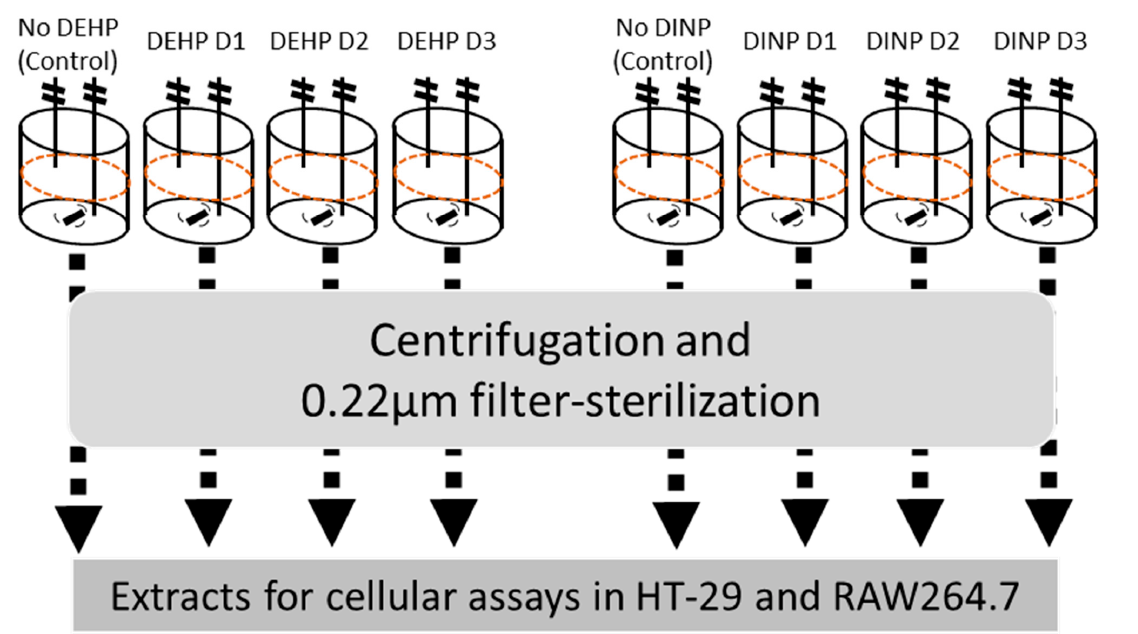
Figure 1. Experimental workflow. After 24 h fermentation, sterilized luminal extracts from fermenters treated with no plasticizer control, DEHP or DINP were used for cell assays in vitro utilizing human intestinal epithelial cell line HT-29 and murine macrophage cell line RAW264.7.